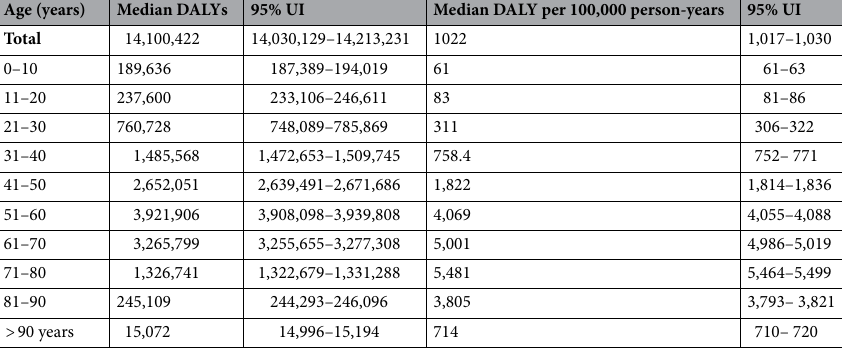
Table 2. Estimated annual disability-adjusted life years (DALYs) due to excess COVID-19 deaths in various age groups in 2020 in India. 95% UI = 2.5–97.5th